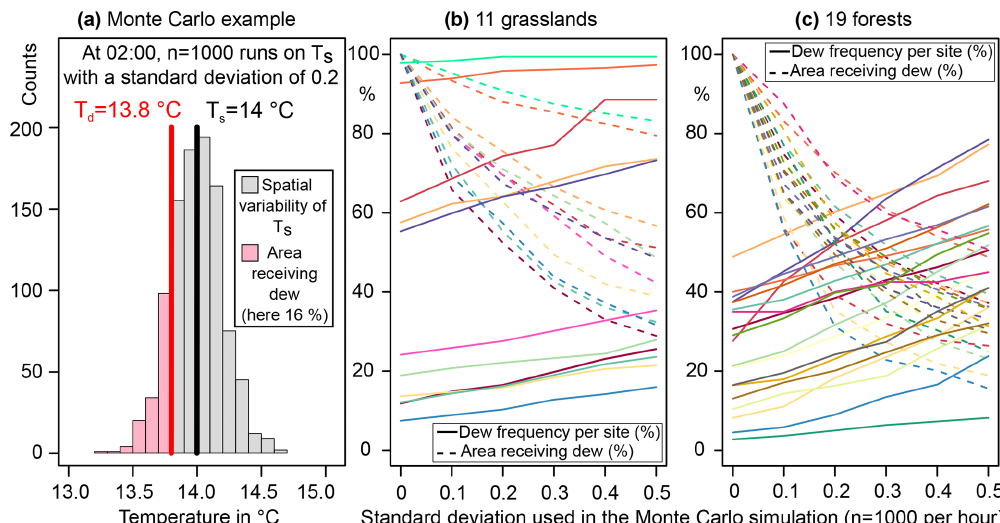
Figure 11. Sensitivity of dew frequency to the spatial variability in the surface temperature based on a Monte Carlo simulation run on each half-hour data point ( n = 1000 runs). The spatial variability is assumed to follow a normal distribution, and only a certain percentage of the canopy will receive dew formation (example for a , 16% at 02:00). The Monte Carlo simulation has been run with different standard deviations (from 0 to 0.5) for each half-hour for all grasslands (b) and all forests (c) . A non-dew event is defined here as less than 5% of the canopy receiving dew formation; then all the areas above 5% have been averaged for each site (dashed lines). Colors allow association between the solid lines and the dashed lines for each